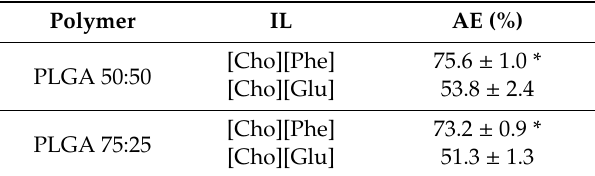
Table 2. Association E ffi ciency (AE) of rutin-loaded ILs-polymer nanoparticle hybrid system. Data represented as mean ± SD ( n = 3). Results are significantly di ff erent ( p < 0.05) between ILs for each polymer, when marked with